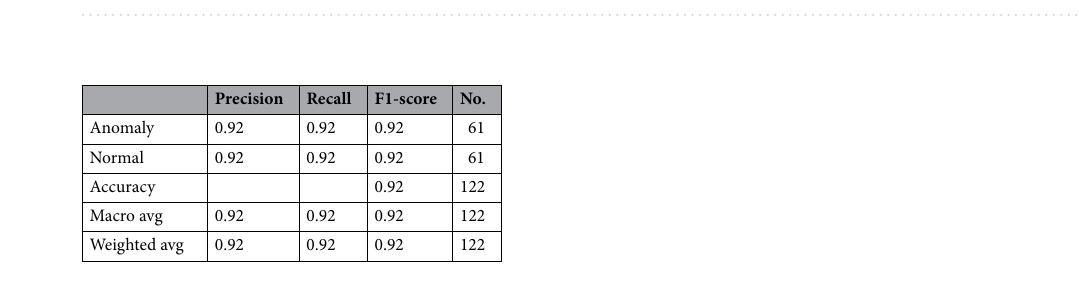
Table 7. The classification results of CNN and attention-based LSTM using ReLU. No. indicates the number of samples.